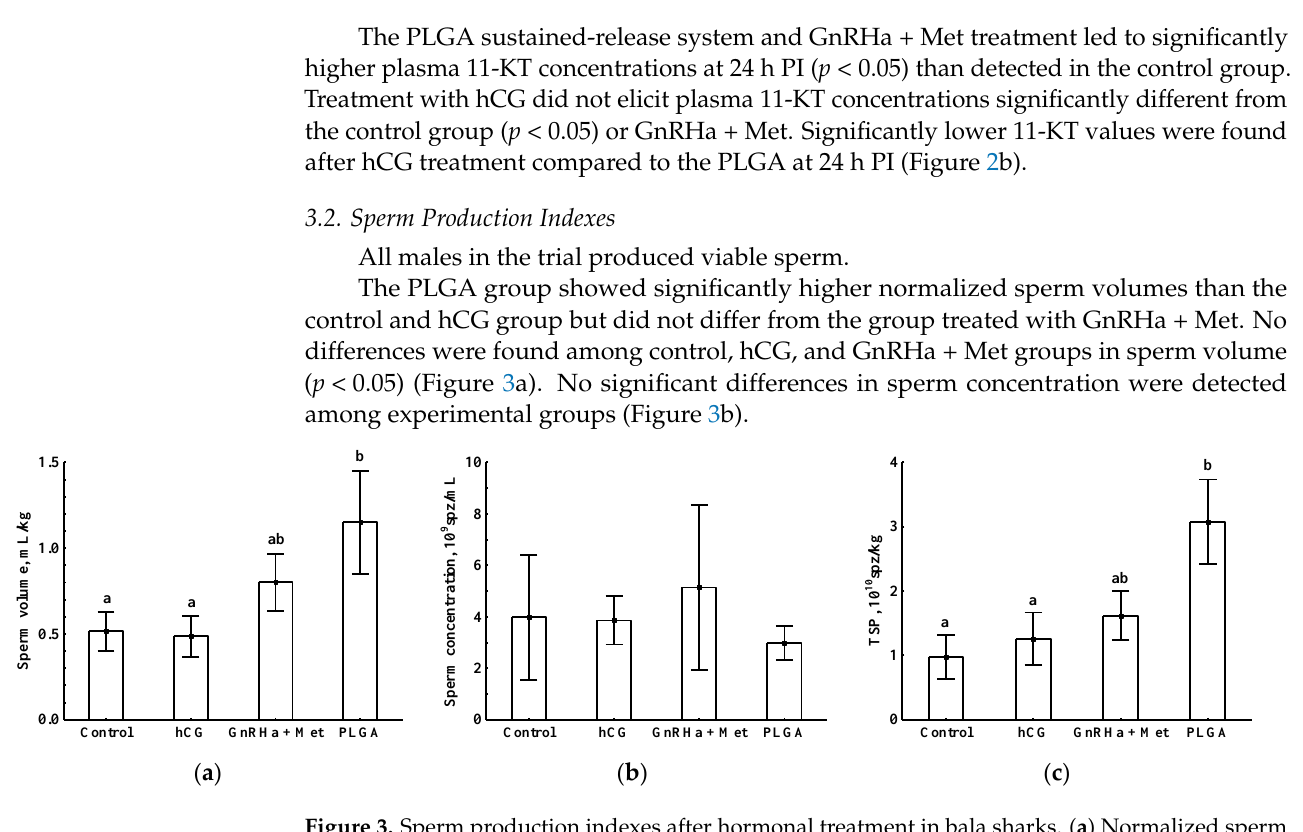
Figure 2. ( a ) Plasma testosterone (T) concentrations in bala sharks after hormone treatment; ( b ) plasma 11-ketotestosterone (11-KT) concentration after hormone treatment in bala sharks. Control (1 mL/kg 0.9% NaCl); hCG (20 μg/kg recombinant hCG); GnRHa + Met (25 μg/kg [D -Ala 6 , Pro 9 , NEt]-GnRH with 20 mg/kg metoclopramide); PLGA (PLGA microparticles). Different letters indicate significant differences ( p < 0.05; Kruskal – Wallis test, multiple comparisons of mean ranks for all groups). Data are expressed as the mean ± SE.